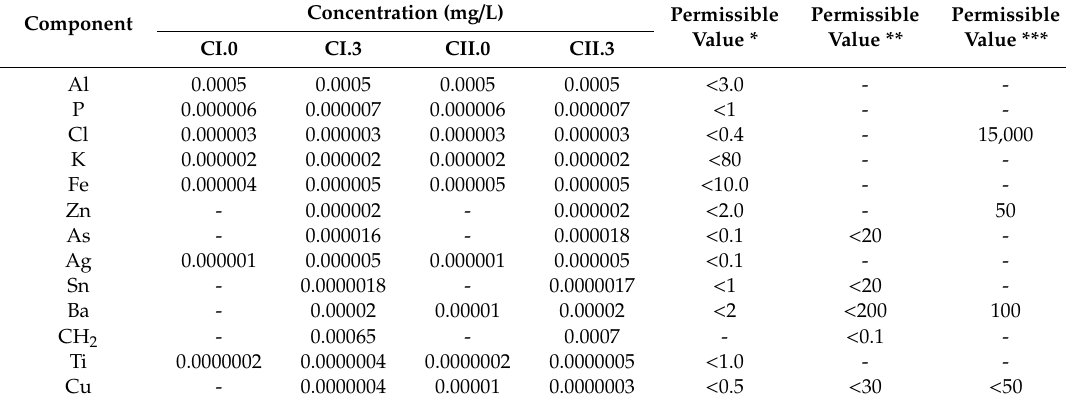
Table 11. Comparison of the values of elements leached from an concrete without and with 3% LCD and permissible values according to selected regulations (mg /